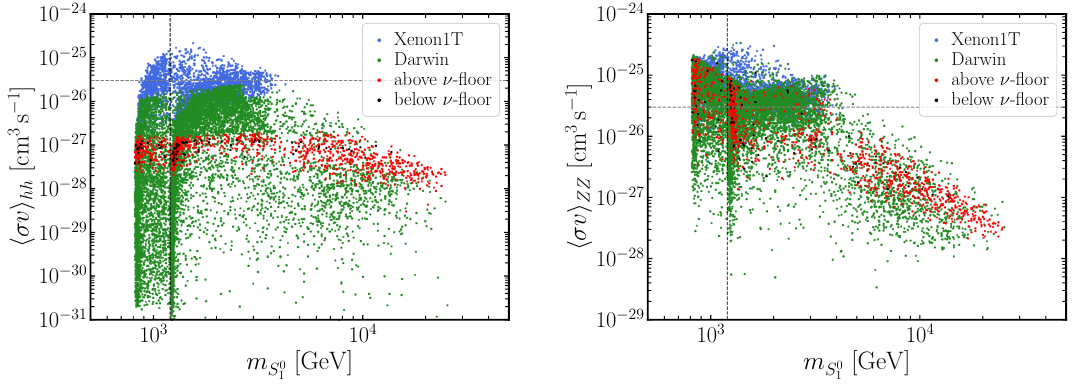
Figure 8 . Scan in the parameter space: dark matter velocity averaged annihilation cross section into hh (left) and ZZ (right). The color code is the same as in figure 5, as described in section 3.2.